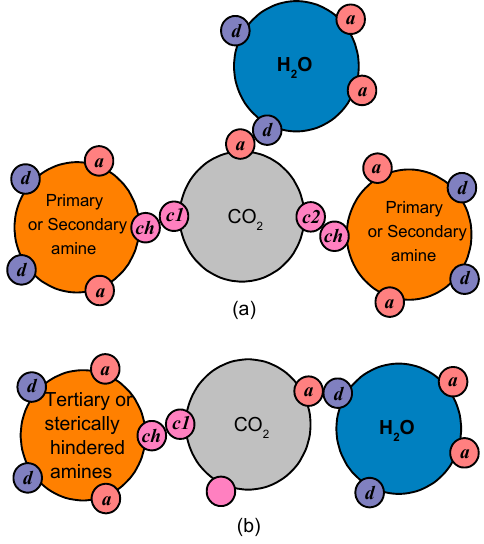
Figure 11. The pseudo-chemical interactions for unhindered primary or secondary amines ( a ) and sterically hindered amines ( b ). The association sites are presented, i.e., sites for chemical interactions ( ch , c 1, c 2), as well as proton donor ( d ) and proton acceptor sites ( a ) capable of hydrogen bonding.